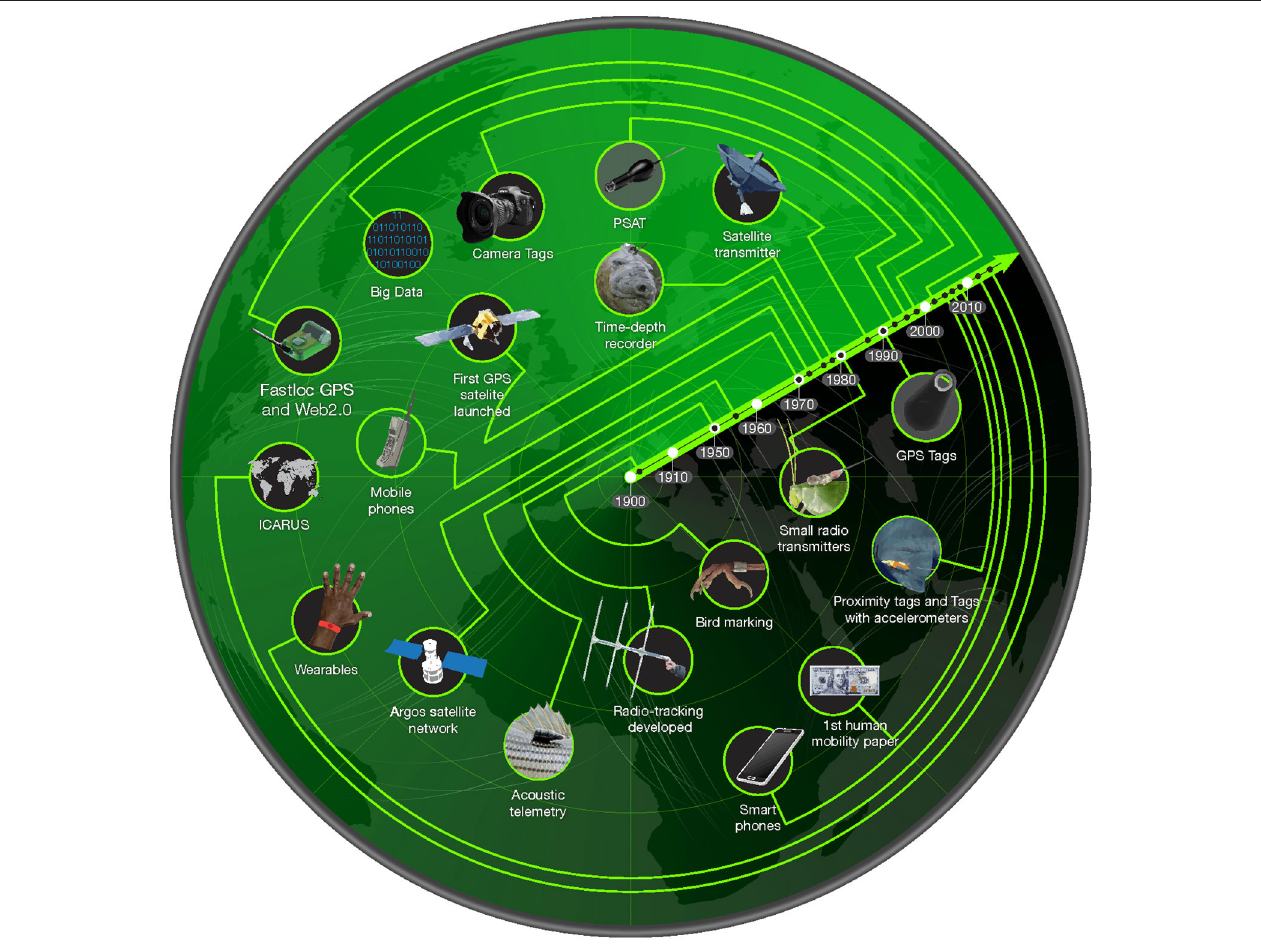
FIGURE 1 | Timeline of Technological Advances in Animal Movement and Human Mobility. The timeline shows the technological advances from animal movement and human mobility research since 1900 to present. Pop-up satellite archival tags (PSATs) are data loggers with a means to transmit the collected data via satellite developed for gill-breathing animals that spend little time at the surface. The International Cooperation for Animal Research Using Space Initiative (ICARUS) is a new animal tracking antenna on the International Space Station that would allow smaller tags to send data back through the low-orbit satellite. The dollar bill represents the first published paper on human mobility, which tracked records of dollar bills across the United States as a proxy for human movement (Brockmann et al., 2006). GPS = global positioning system. Reprinted from Trends in Ecology and Evolution (see Meekan et al., 2017), with permission from